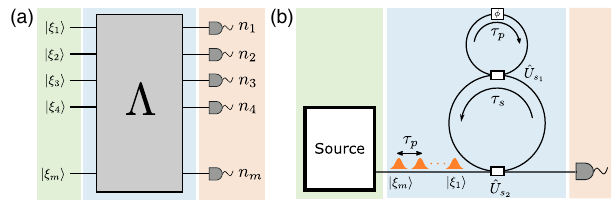
FIG. 1. (a) General GBS picture, where we have an m -mode Gaussian state going into an interferometer described by the transfer matrix Λ and then detected using single-photon detectors. (b) Time-bin encoded architecture to implement GBS experi- ments. The modes are defined by temporal bins, and the interferometer is implemented by optical loops. One light source generates the multimode input state, which is detected at the output by one single-photon